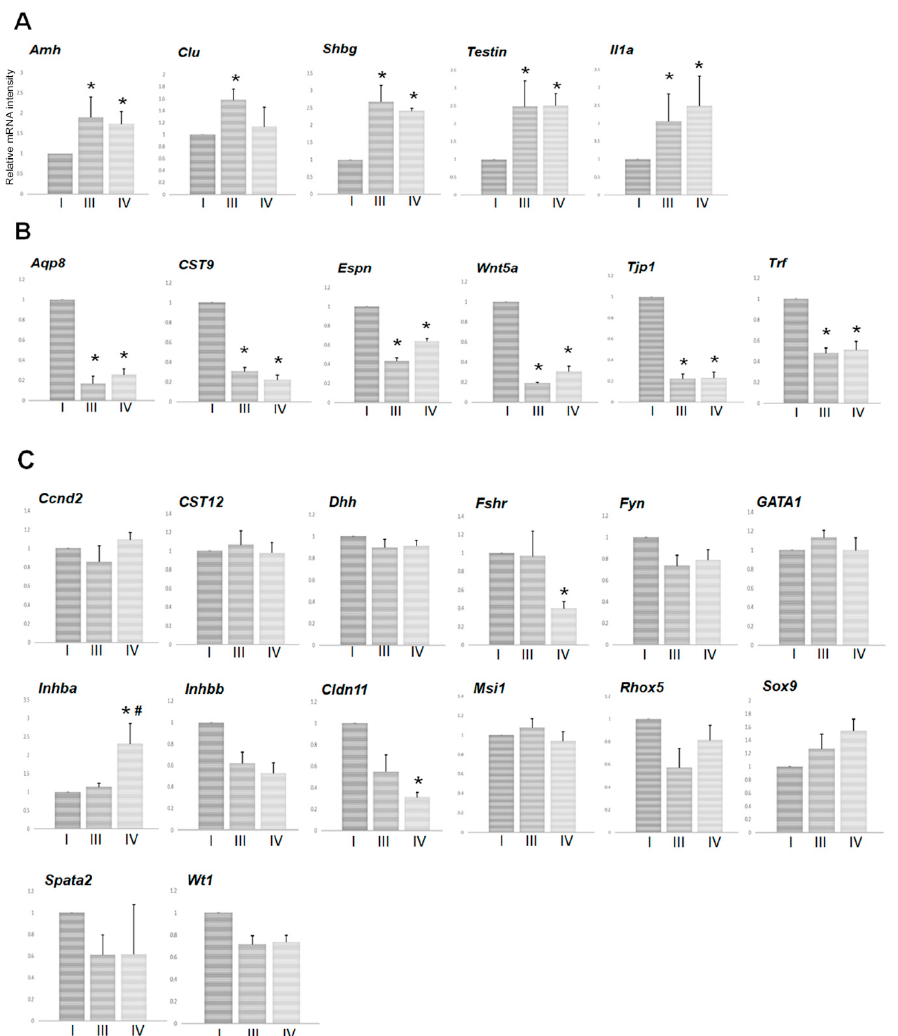
Figure 4. Effect of TL107 on the expression levels of 25 mRNA transcripts encoding markers of Sertoli cell-specific products in groups I, III, and IV mice at day 60: expression was measured by real-time RT PCR, and the results are expressed relative to the internal control GAPDH . The results are expressed as the mean values ± standard deviation of five mice in each group, and the y-axis shows relative mRNA intensity. Transcripts showing a significant increase in levels after BSF treatment compared to control values are grouped in ( A ); transcripts showing a significant decreased in levels after BSF treatment compared to control values are grouped in ( B ); and transcripts showing no change in levels after BSF treatment are grouped in ( C ). * p < 0.05 vs. group I; # p < 0.05 vs. group III. We have previously demonstrated that TJ107 or administration of Hachimi-jio-gan (TJ7) and Hochu-ekki-to (TJ41) in combination were able to completely normalize testicular immunopathology